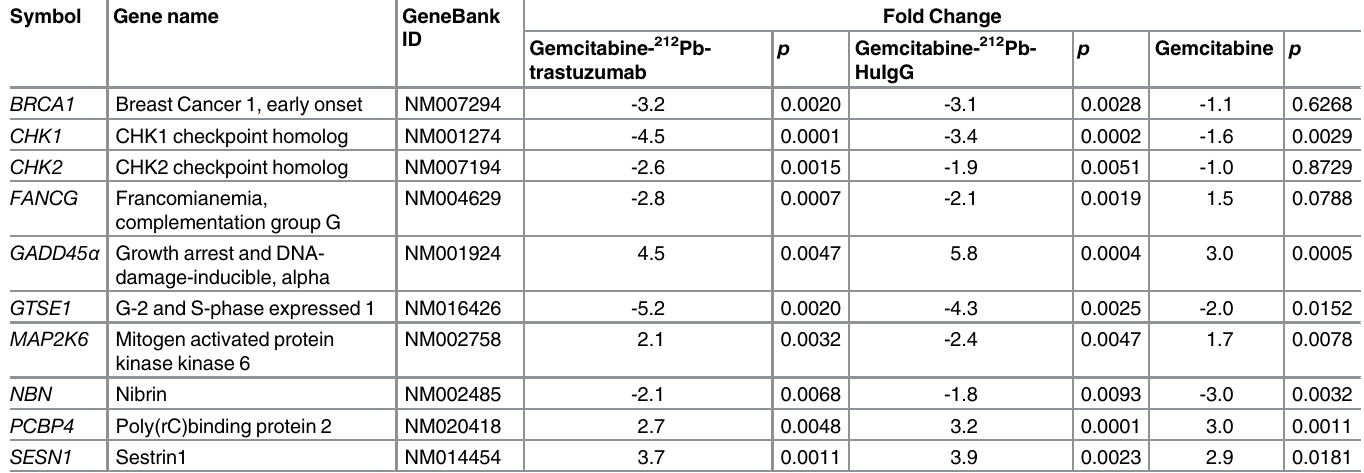
Table 2. Differential expression of genes involved in cell cycle in LS-174T i.p. xenografts by Gemcitabine and α -treatment.